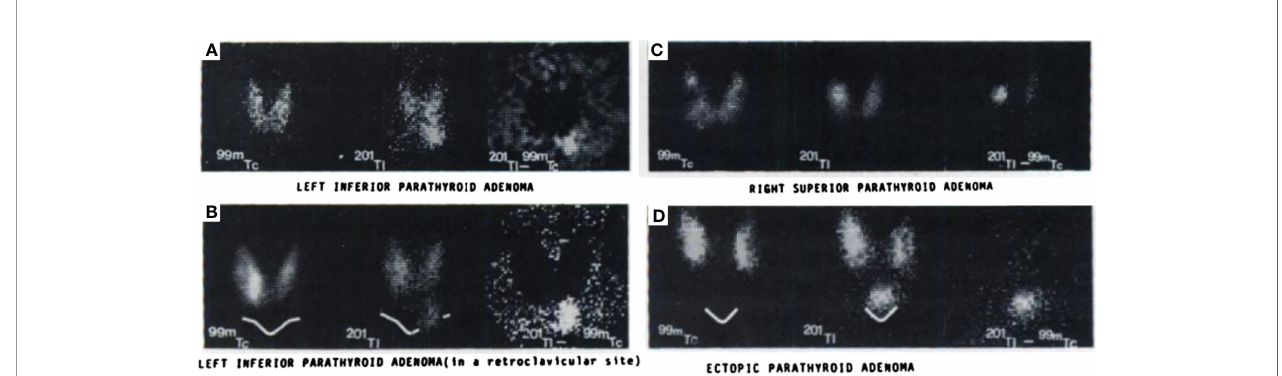
FIGURE 3 | Early examples of parathyroid pathology detection using 99m Tc-pertechnetate and thallium subtraction scintigraphy. Upper left panel (A) depicts 99m Tc- pertechnetate thyroid uptake on the left image, 201 Tl uptake in the middle image, and the subtraction image highlighting a left inferior parathyroid adenoma on the right image. Lower left panel (B) depicts a similar 201 Tl minus 99m Tc-pertechnetate series of three images of a left inferior parathyroid adenoma with decreased signal to noise ratio due to its location behind the clavicle contributing to increased attenuation relative to the series above. Right upper panel (C) depicts a similar subtraction series of a right superior parathyroid adenoma. Right lower panel (D) depicts a subtraction series of an ectopic parathyroid adenoma near the sternal notch. Reproduced with permission from: Ferlin G, Borsato N, Camerani M, Conte N, Zotti D. New perspectives in localizing enlarged parathyroids by technetium- thallium subtraction scan. J Nucl Med. 1983 May;24(5):438-41. PMID: 6842292